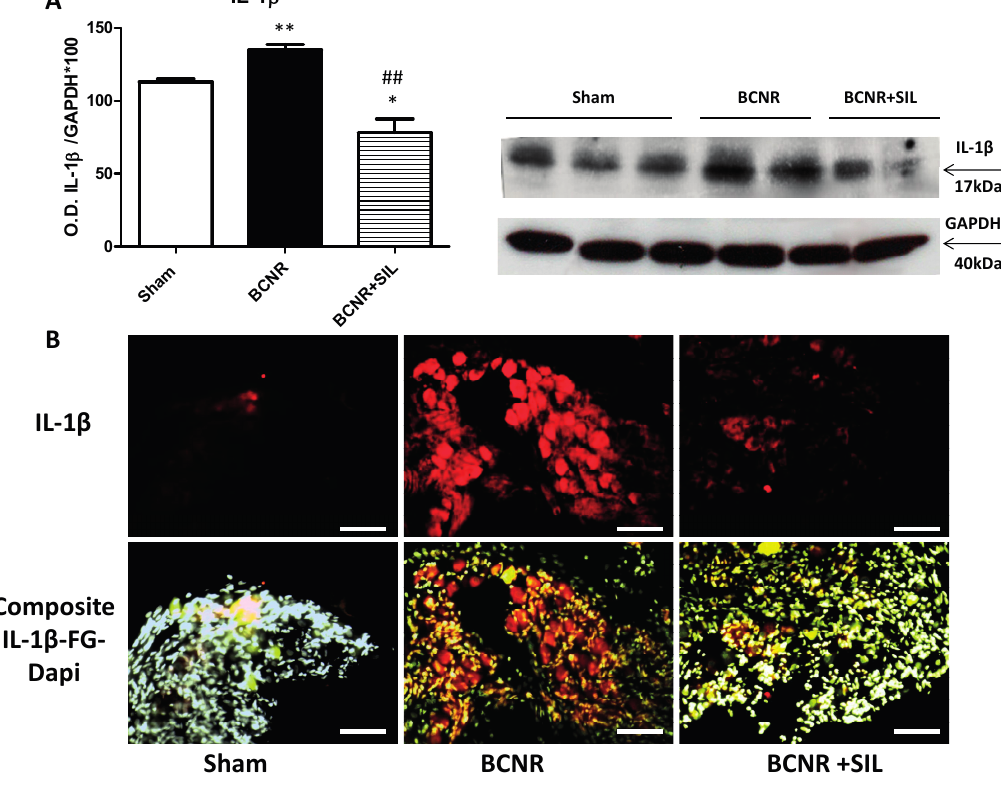
Figure 2. Sildenafil down regulates the expression of inflammatory cytokine IL-1 β in the pelvic ganglia after BCNR. ( A ) Protein extracts were subjected to Western blot analysis for IL-1 β and normalized by GAPDH with the correspondent densitometric analysis. * p < 0.05; ** p < 0.01 respect to sham. ## p < 0.01 respect to BCNR; ( B ) Frozen pelvic ganglia sections were immunostained with a polyclonal antibody against IL-1 β followed by a biotinylated secondary antibody and streptavidin conjugated with Texas red. Red: IL-1 β , Yellow: FG. White: DAPI. Magnification 100×; Bar = 100